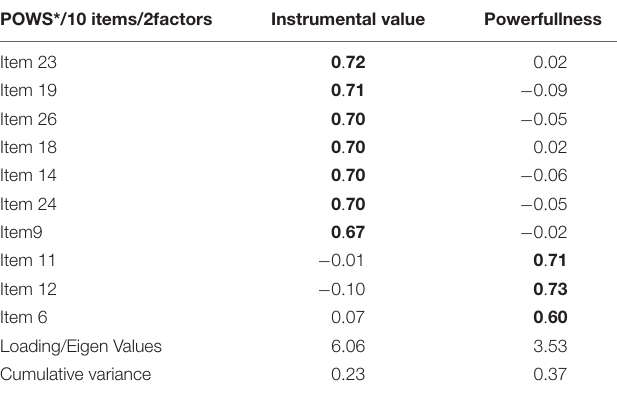
TABLE 3 | Factor loadings estimates for POWS with oblimin rotation ( N =